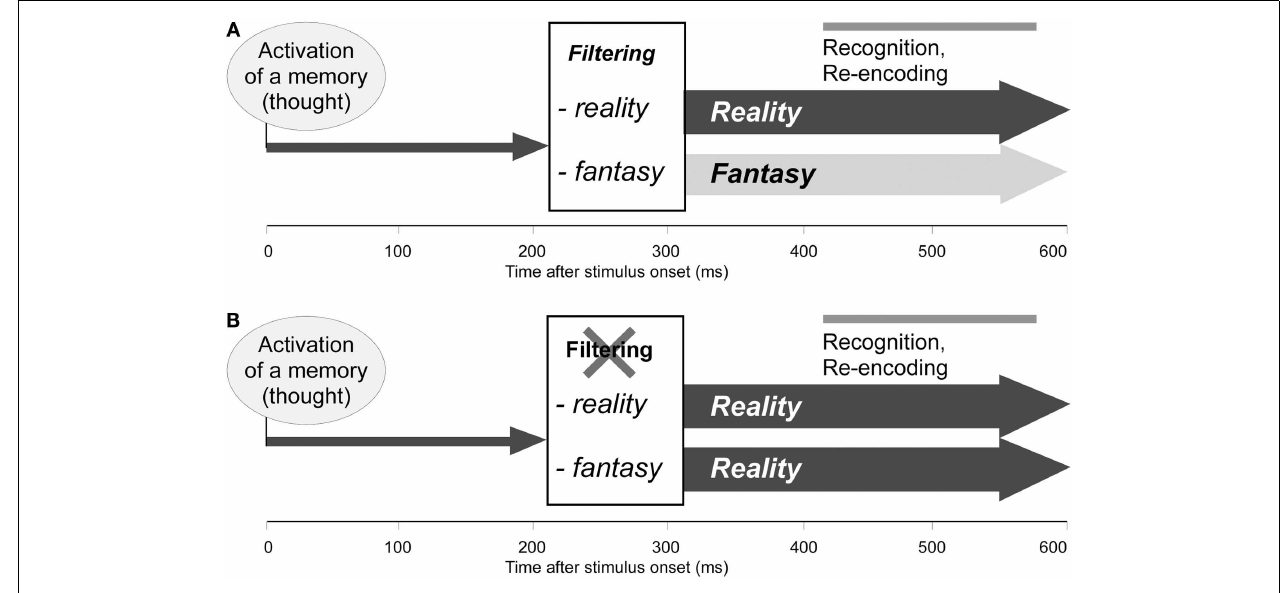
Wahlen et al., 2011). (B) Hypothetical dysfunction of reality filtering in reality-confusing patients: memories (thoughts) are normally activated, but are not checked regarding their relation with reality; all memories are activated, and later recognized and re-encoded, as if they related to ongoing reality. Adapted from Schnider (2008), with